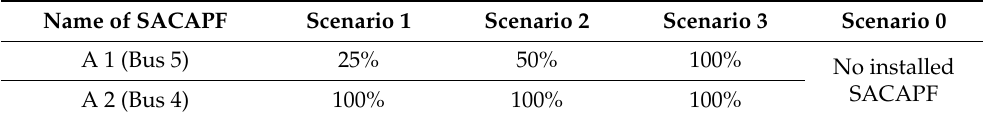
Table 4. Ratings of SACAPFs in comparison to harmonic content of nonlinear load.